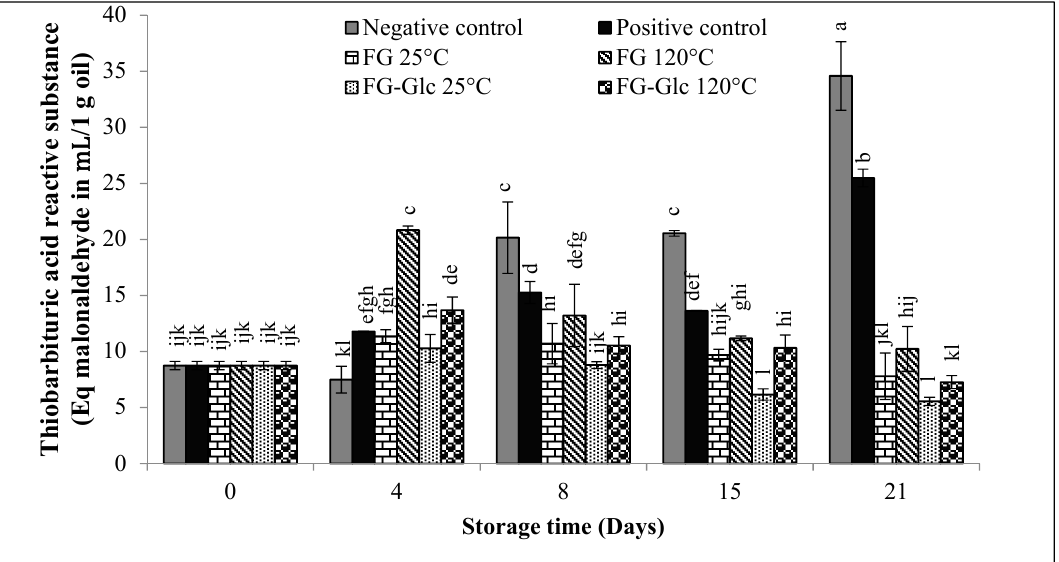
Figure 3. Thiobarbituric acid reactive substances of flaxseed oil packaged or not in different gelatin pouches as a function of storage time. Means with different superscripts (a-l) indicate a significant difference ( p ˂ 0.05).